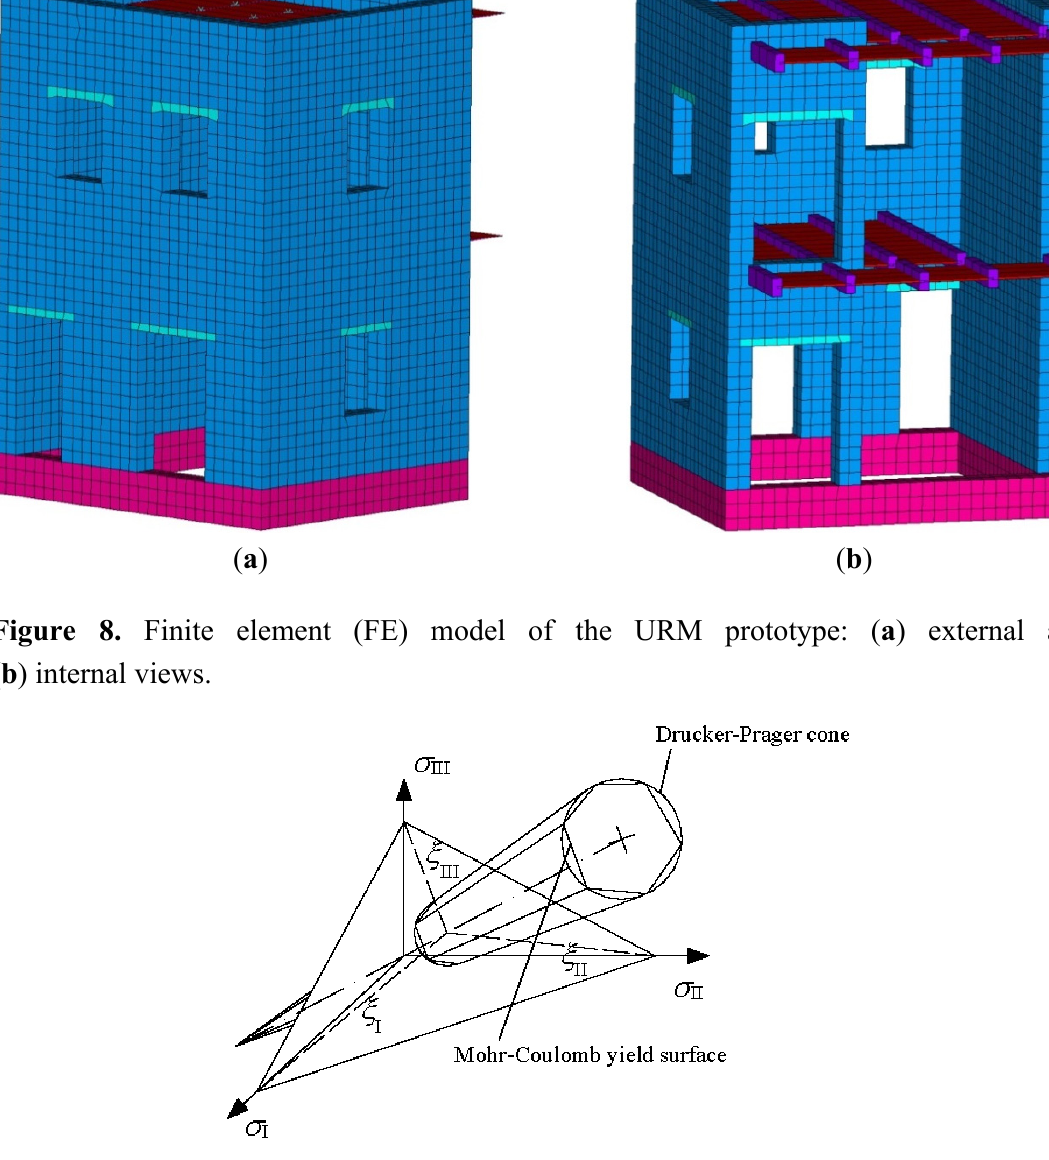
Figure 9. Drucker–Prager yield surface in the Haigh–Westergaard stress